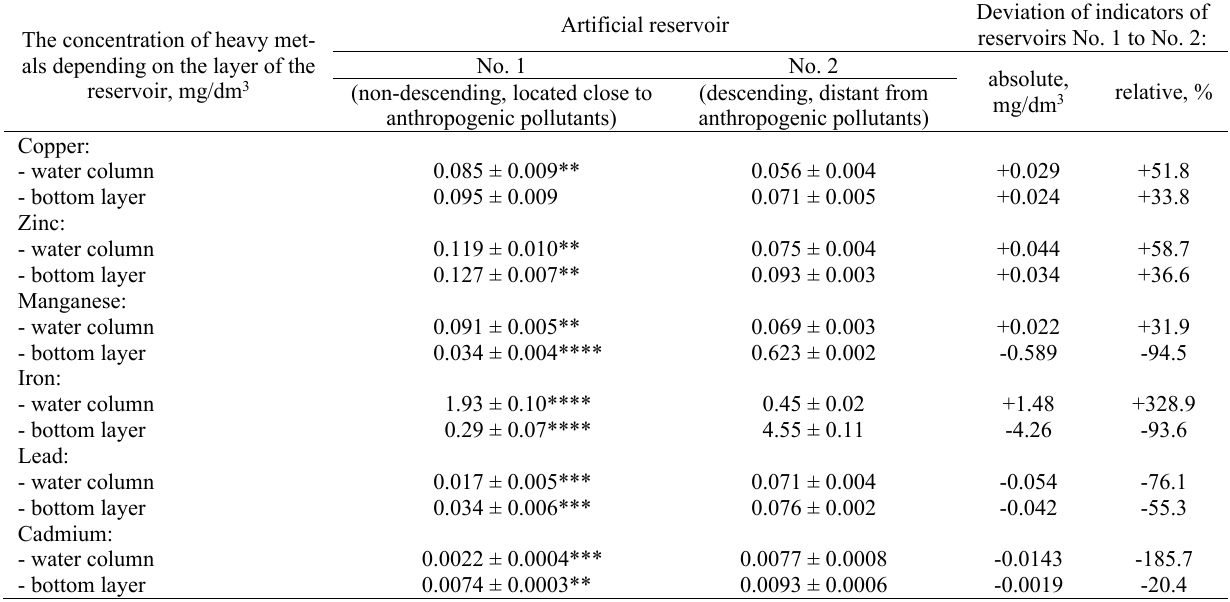
The concentration of heavy metals depending on a number of anthropogenic factors (М ± m, n =